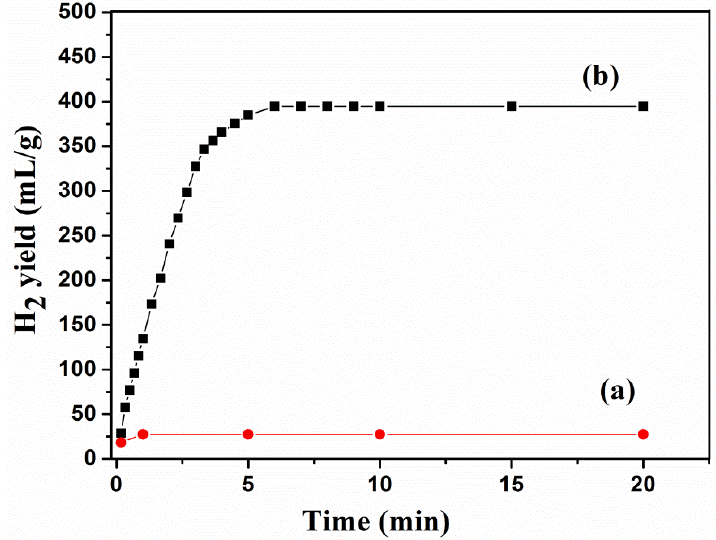
Figure 5. The hydrogen evolution curves by hydrolysis of as-received MgH 2 (a) and 3 h ball-milled MgH 2 (b) in pure